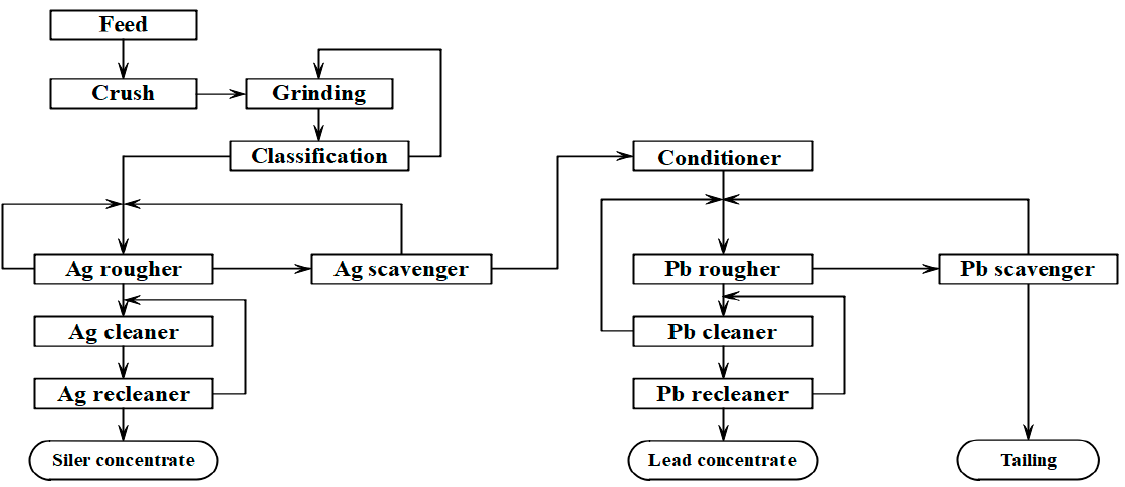
Figure 7. Industrial closed ‐ circuit flotation flowchart. Table 6. Results of the industrial closed ‐ circuit test. Ag Pb Yield (%) Content (g/t) Recovery (%) Content (%) Ag conc.